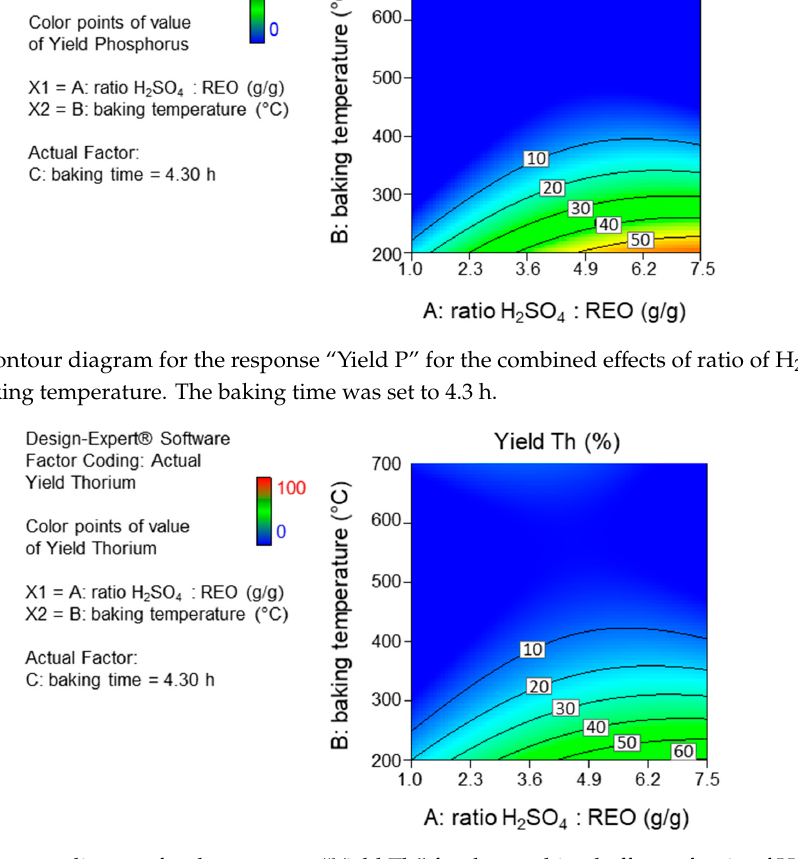
Figure 15. Contour diagram for the response “Yield Th” for the combined effects of ratio of H 2 SO 4 to REO and baking temperature. The baking time was set to 4.3 h.